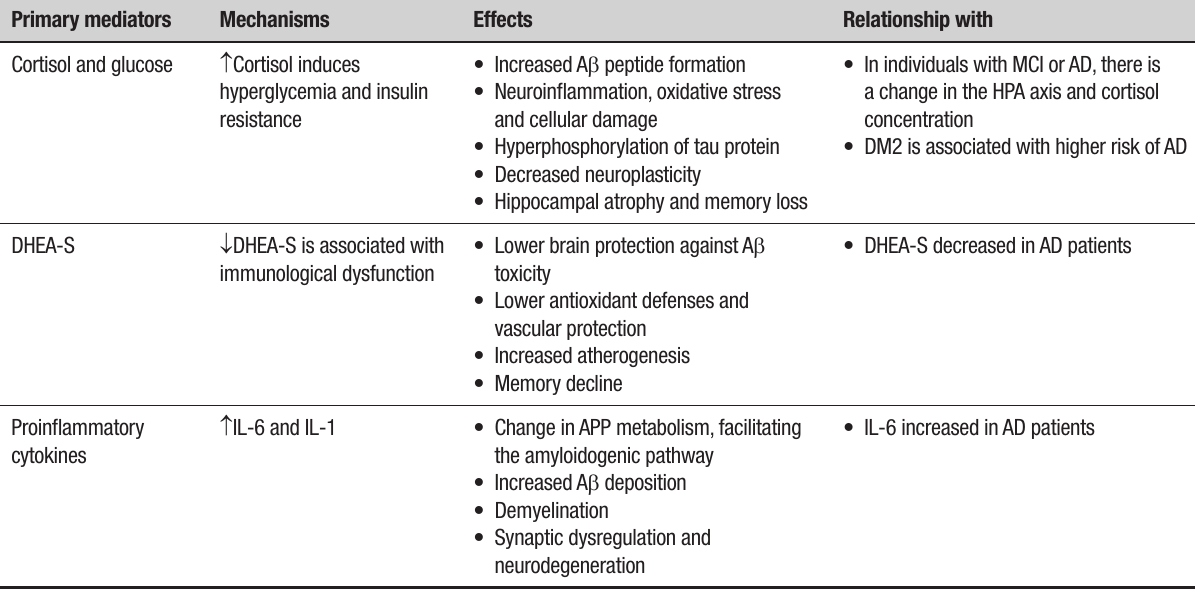
Table 1. Effects of the primary mediators of chronic stress and their similarity with the mechanisms that trigger Alzheimer’s disease. Primary mediators